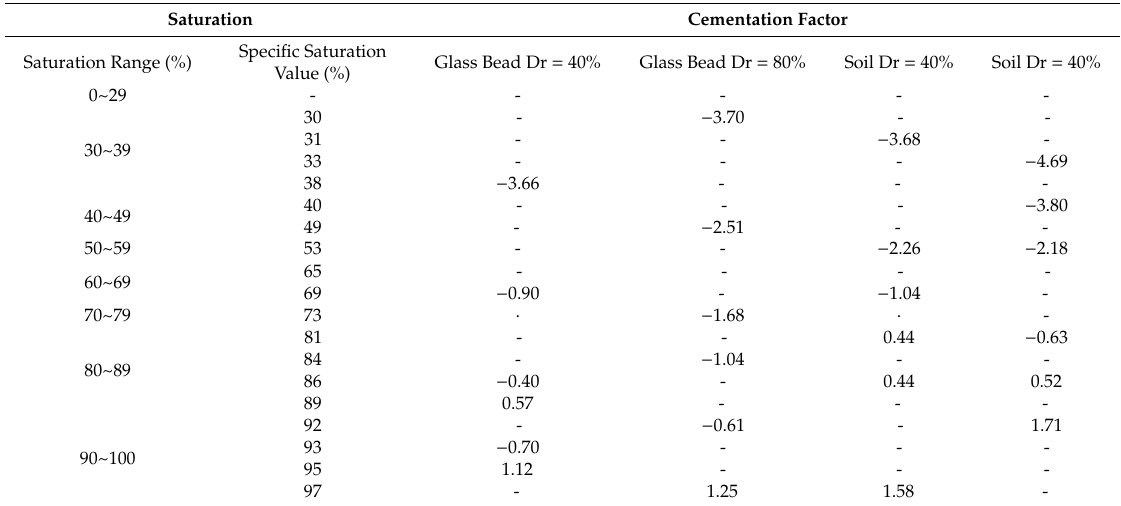
Table 3. Summarized cementation factors for each saturation